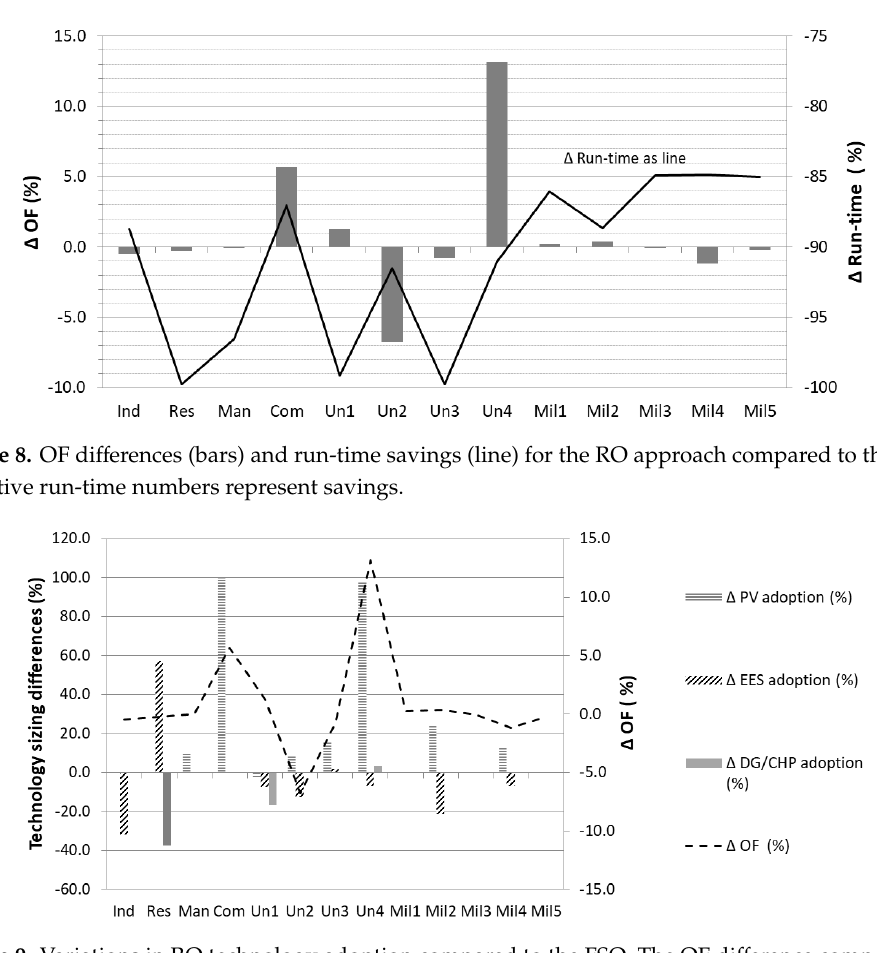
Figure 9. Variations in RO technology adoption compared to the FSO. The OF difference compared to FSO is shown as a dashed line.